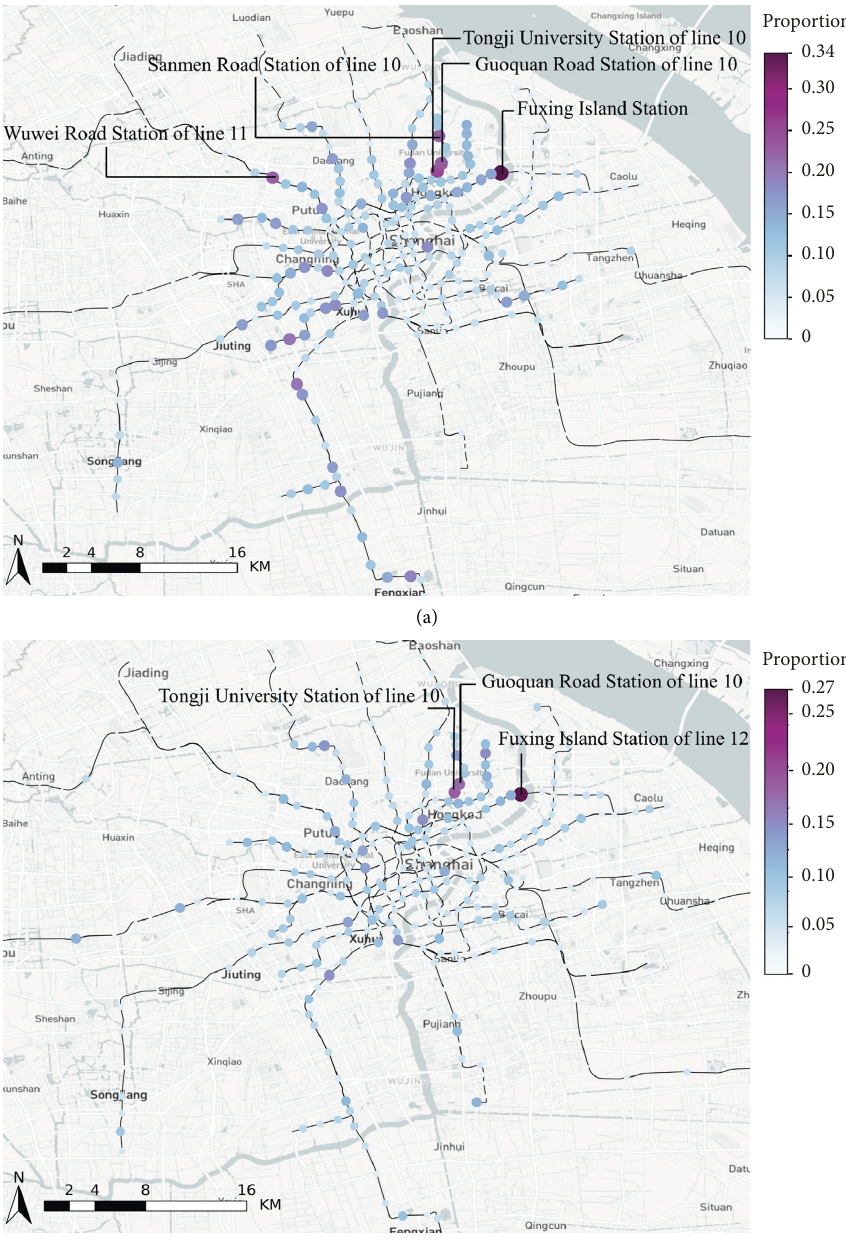
Figure 11: The share of connection around the metro stations. (a) Weekday. (b)